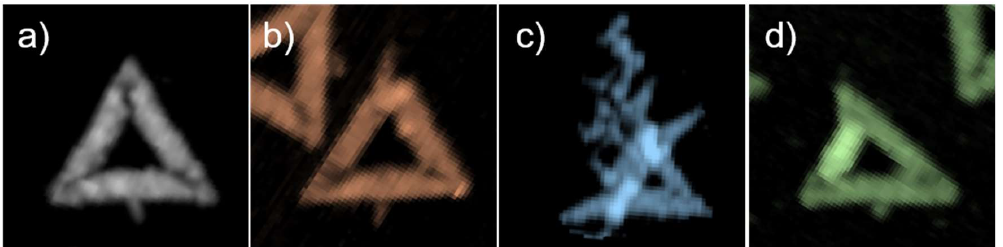
Figure 2. Representative AFM zooms of Rothemund triangles categorized as ( a ) intact, ( b ) broken, ( c ) denatured, and ( d ) deformed.